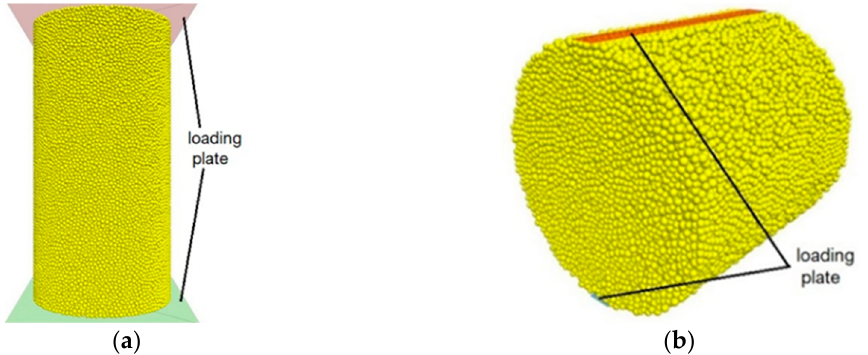
Figur e 8 . Numerical models: ( a ) unconfined compression test; ( b ) splitting test. Figure 8. Numerical models: ( a ) unconfined compression test; ( b ) splitting